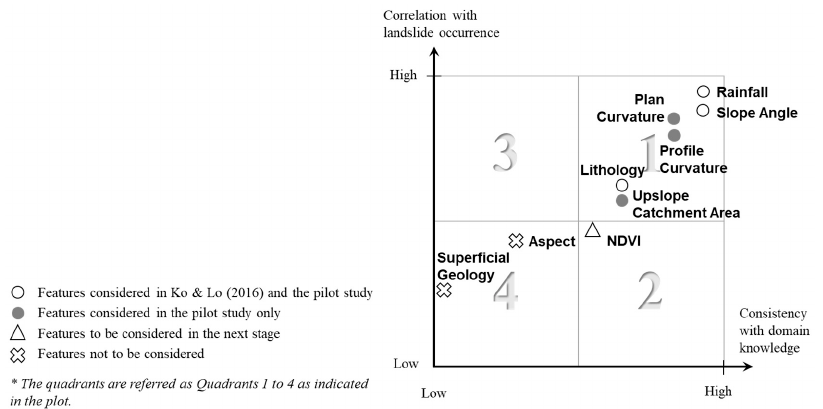
Figure 5. Feature Selection Priority Matrix.